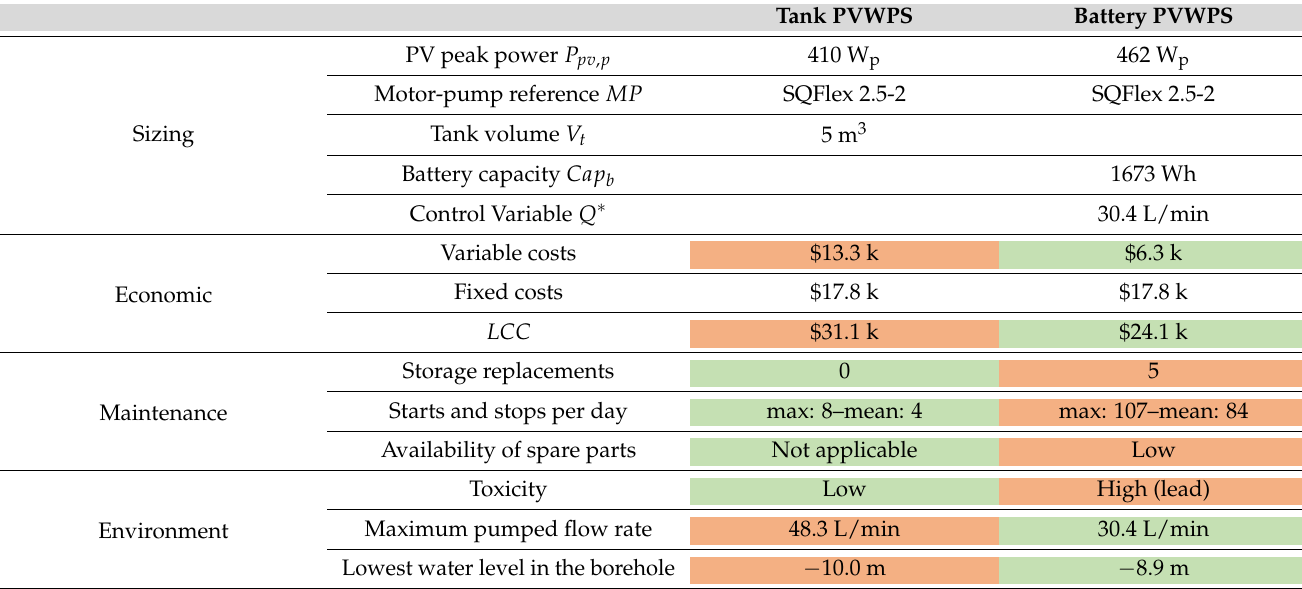
Table 3. Comparison of tank and battery optimal